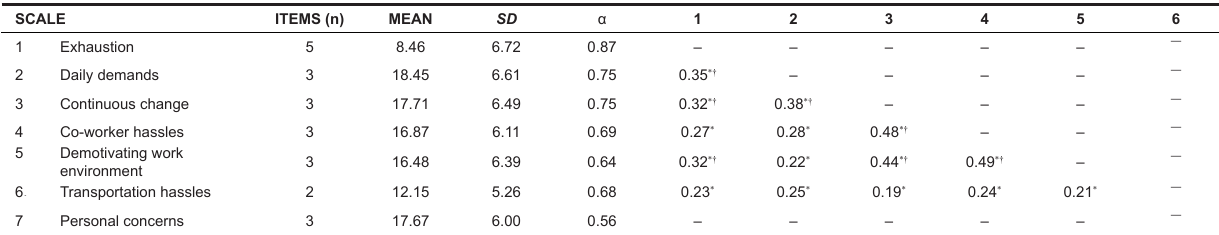
Table 3 Descriptive statistics and product-moment